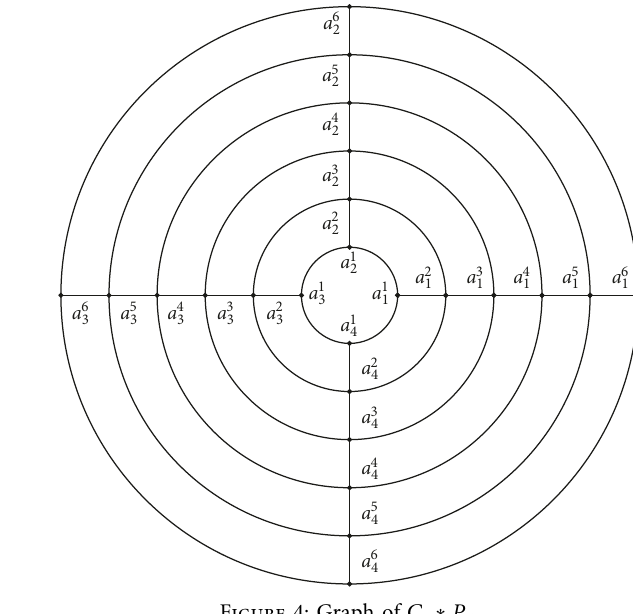
Figure 3: Cycle with chord graph C 8